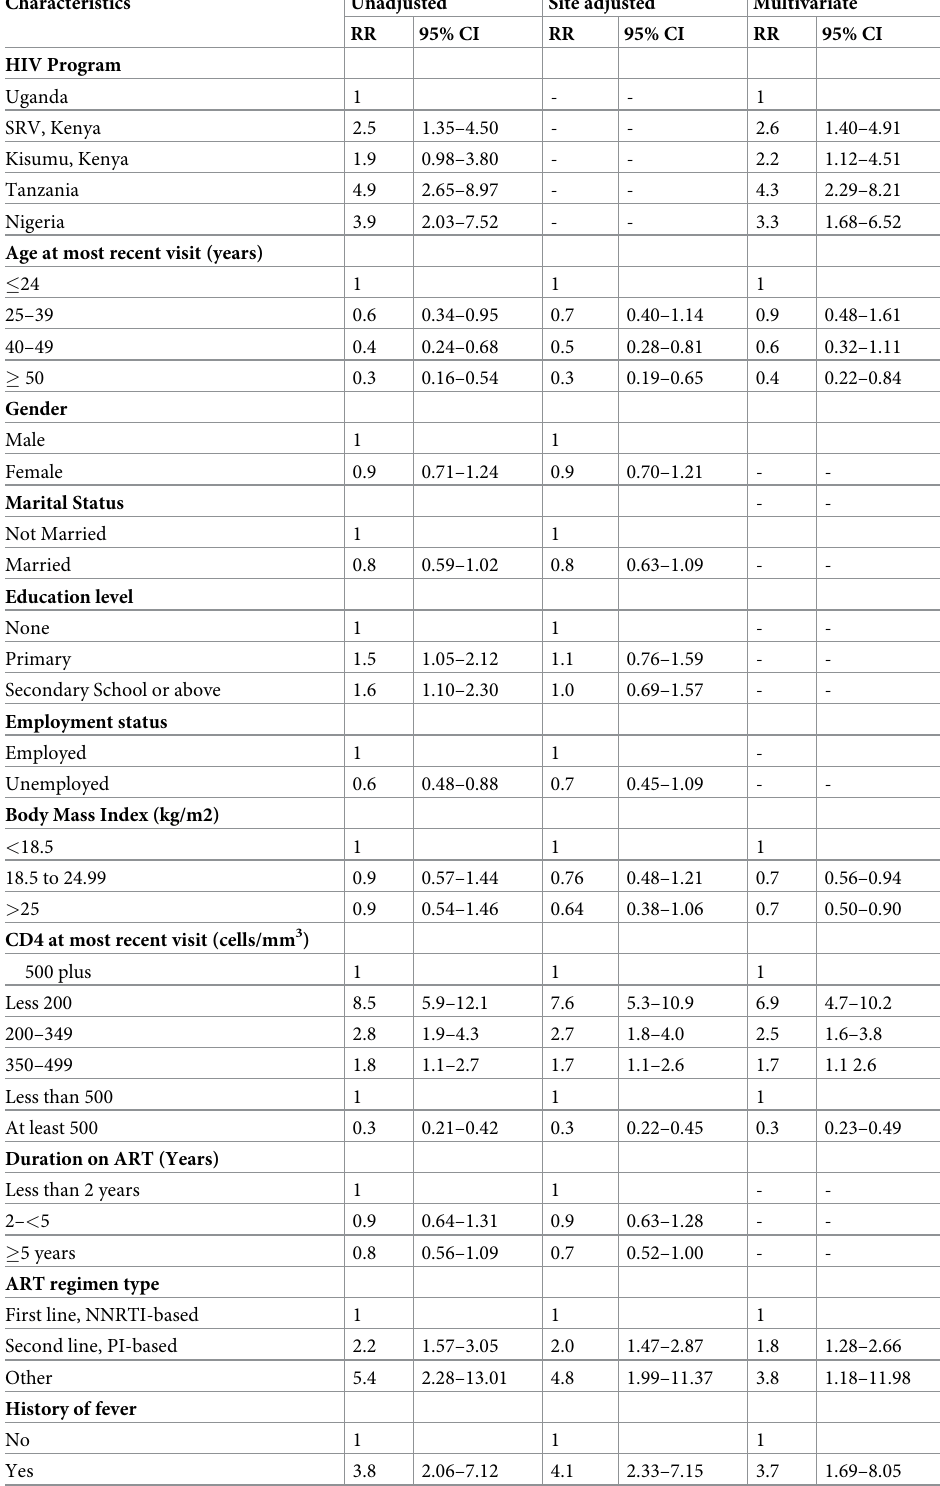
Table 2. Unadjusted and adjusted factors associated with virologic failure (Viral load � 1000 copies/ml).